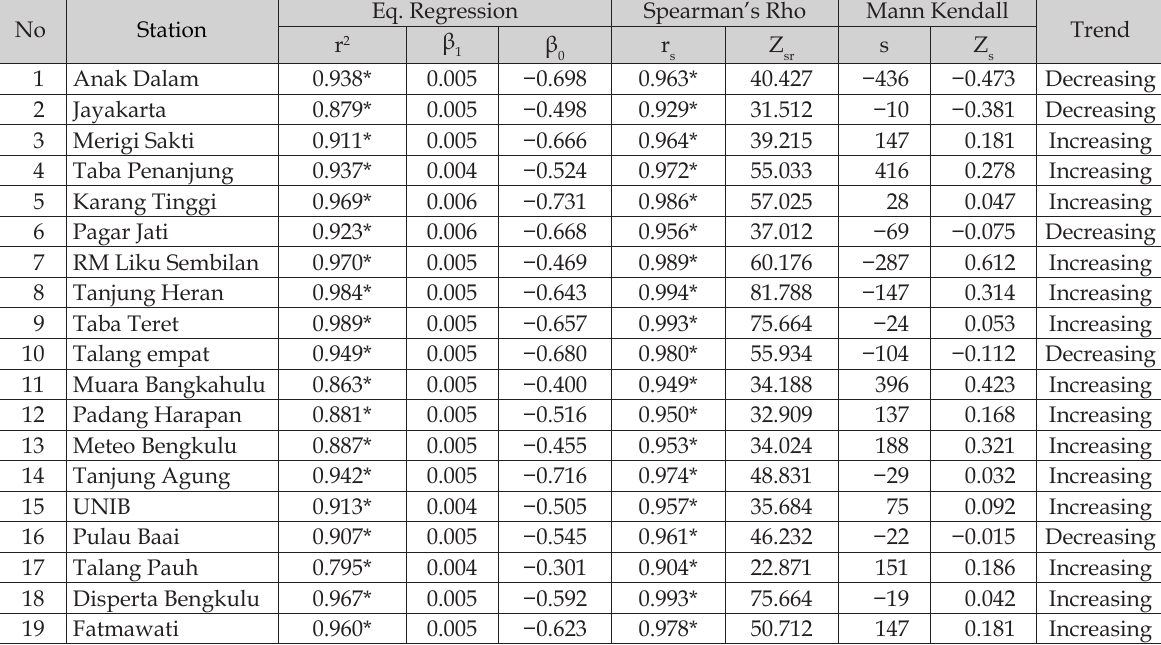
Fig. 4. The boxplots indicate the trends for erosivity density (ED) as the ratio of rainfall erosivity (interpolated erosivity map based on IDW) with monthly rainfall data in the Air Bengkulu watershed. Table 4. Test statistical analysis results for monthly erosivity density